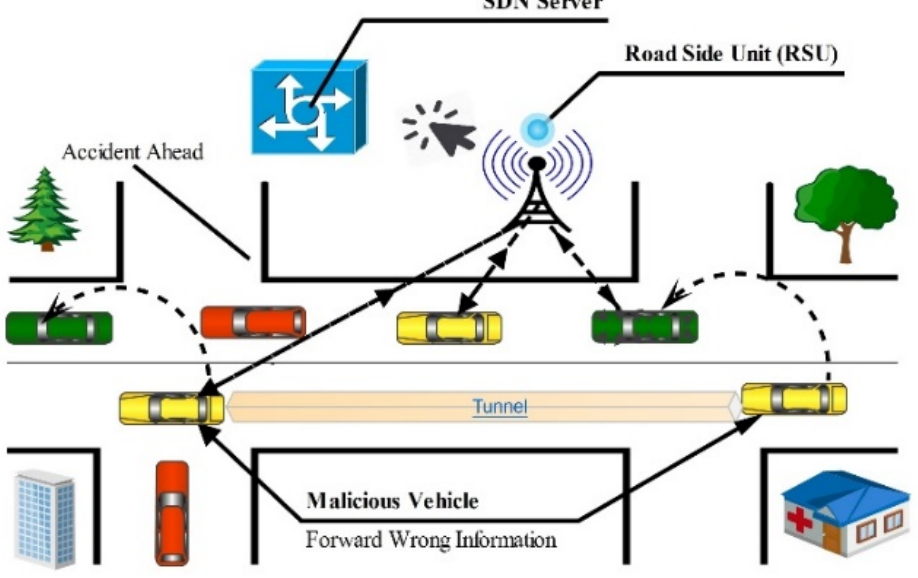
Figure 17. Wormhole attack in SDN-based VANETs.